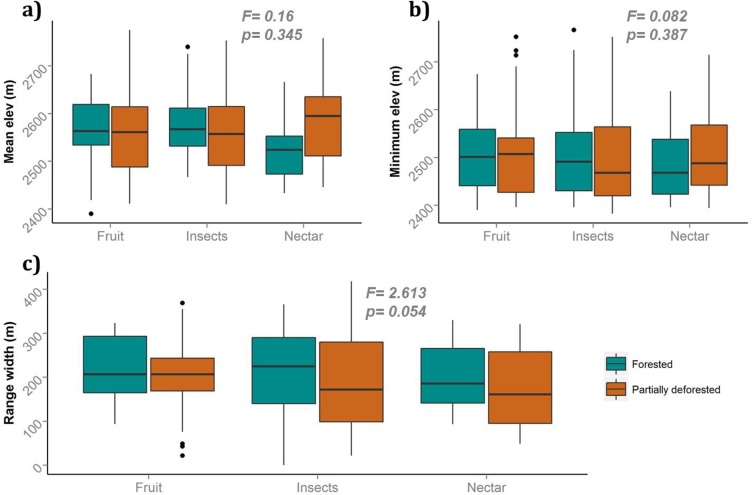
Comparison of elevational range variables per trophic guild for forested and partially deforested transects (p values shown are for one-tailed two-factor ANOVAs).a) Abundance-weighted mean elevation. b) Minimum elevation. c) Elevational range width. Dots represent outliers.